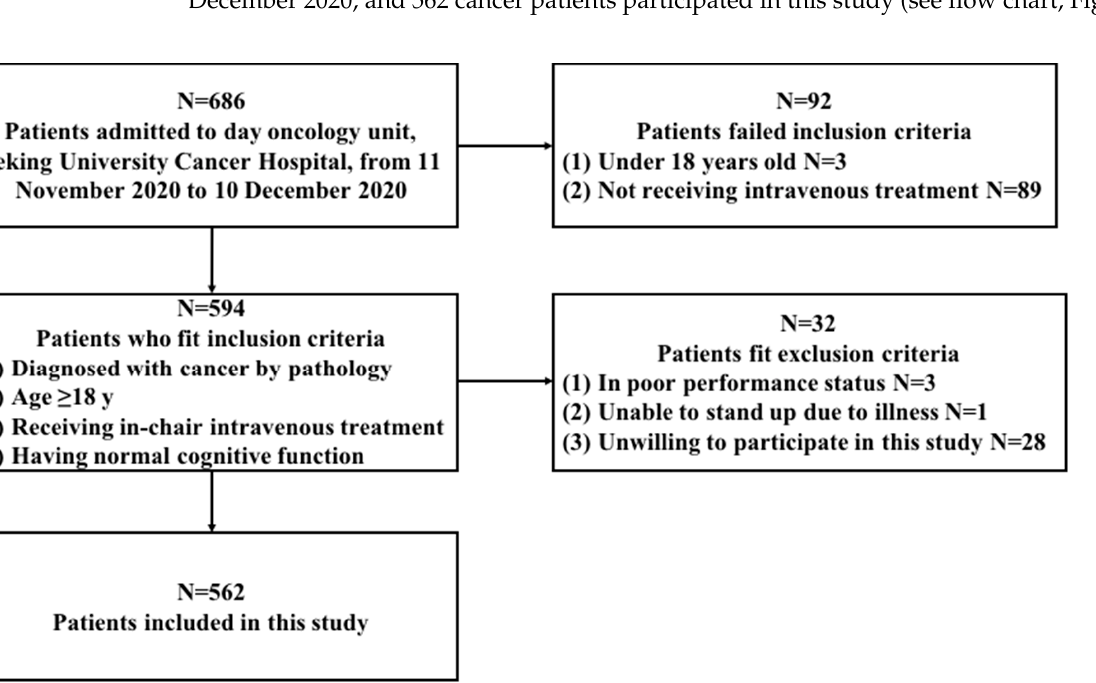
Figure 1. Flow chart. Figure 1. Flow Table 1. Characteristics of 562 patients with cancer enrolled in this study.